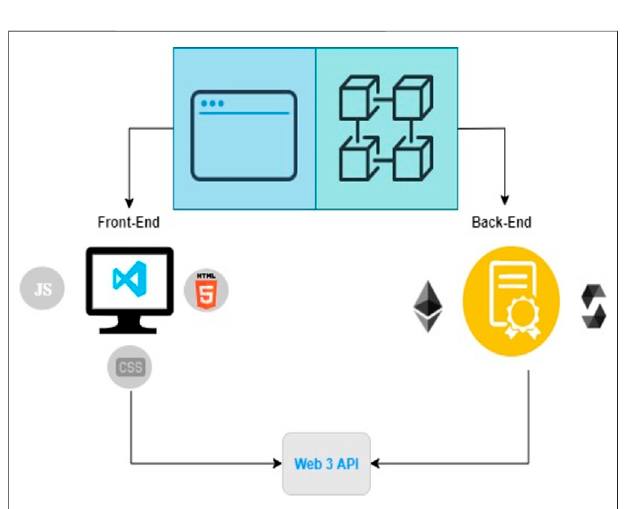
FIGURE 10 | Off-chain components. FIGURE 11 | On-chain system